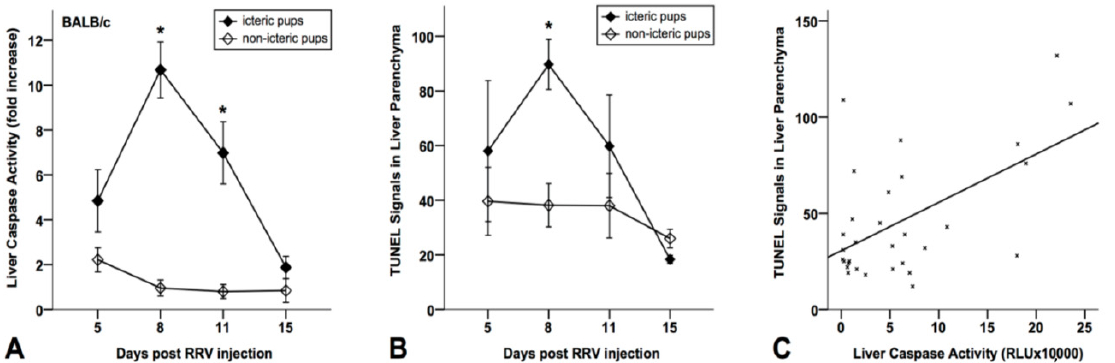
Figure 2. In icteric mice, caspase activity in liver tissues is significantly increased at day 5 and 8 after RRV infection ( A ). At the same time, TUNEL reactivity in liver parenchyma is elevated in both icteric and non-icteric BALB/c mice (mean ± SEM) ( B ). In icteric pups, TUNEL positivity (TUNEL-positive cells in liver parenchyma as average per portal tract) shows a peak at day 8 and decreases by the end of the second week of life. At each time point, every group contains 3 to 6 mice. Significance (*) was confirmed for day 8 ( p = 0.005) ( A ). In 31 mice, the Pearson correlation coefficient between TUNEL-reactivity and luminometrically detected caspase-3/-7 activity in liver tissues was 0.557 ( p = 0.001) ( C